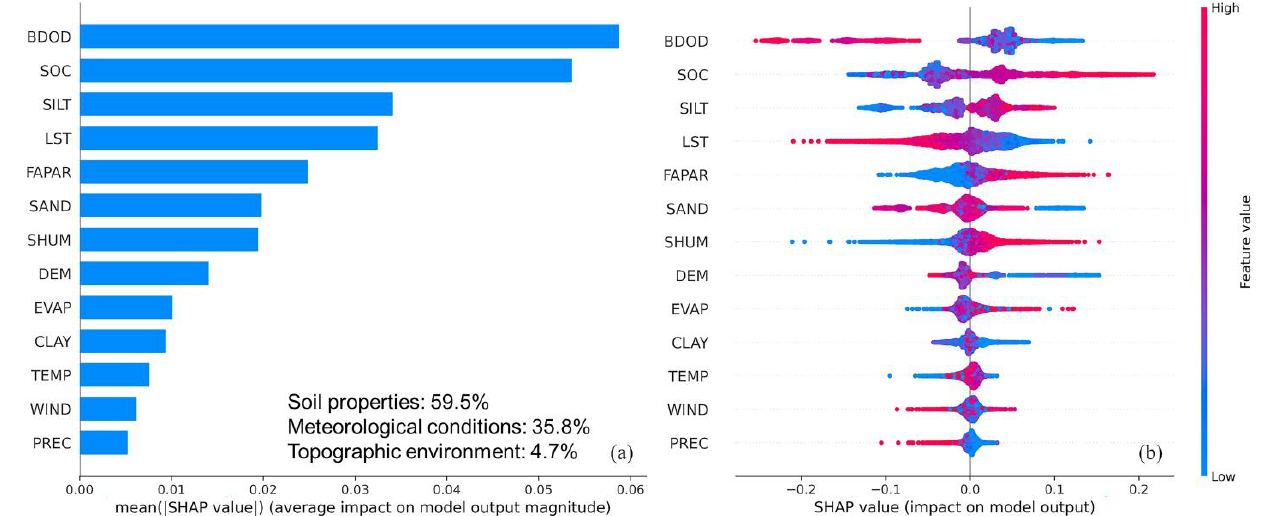
Figure 9. Average SHAP value of every feature ( a ) and SHAP value of every feature for every sample ( b ) in the XGBR model. Soil properties include BDOD, SOC, SLIT, SAND and CLAY; meteorological conditions include LST, FAPAR, SHUM, EVAP, TEMP, WIND and PREC; and topographic environment includes DEM.